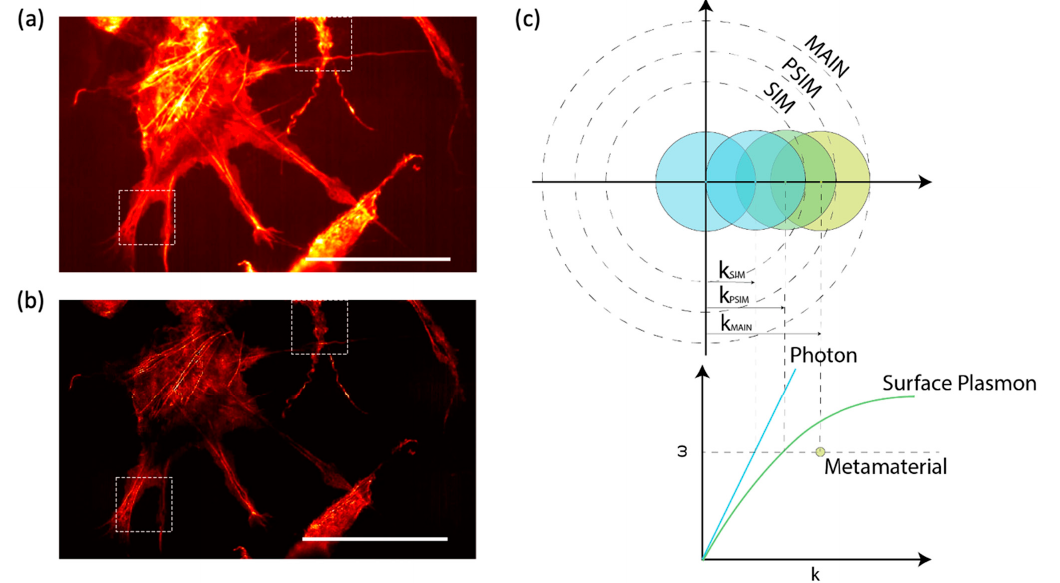
Figure 10. Metamaterial-based super resolution microscopy. ( a ). Diffraction limited image using conventional epifluorescence. Scale: 20 μ m ( b ) speckle-MAIN image with improved spatial resolution. Reprinted from Ref. [98]. ( c ) the dispersion relation for SIM, PSIM and MAIN and their corresponding k-space shift in Fourier plane.